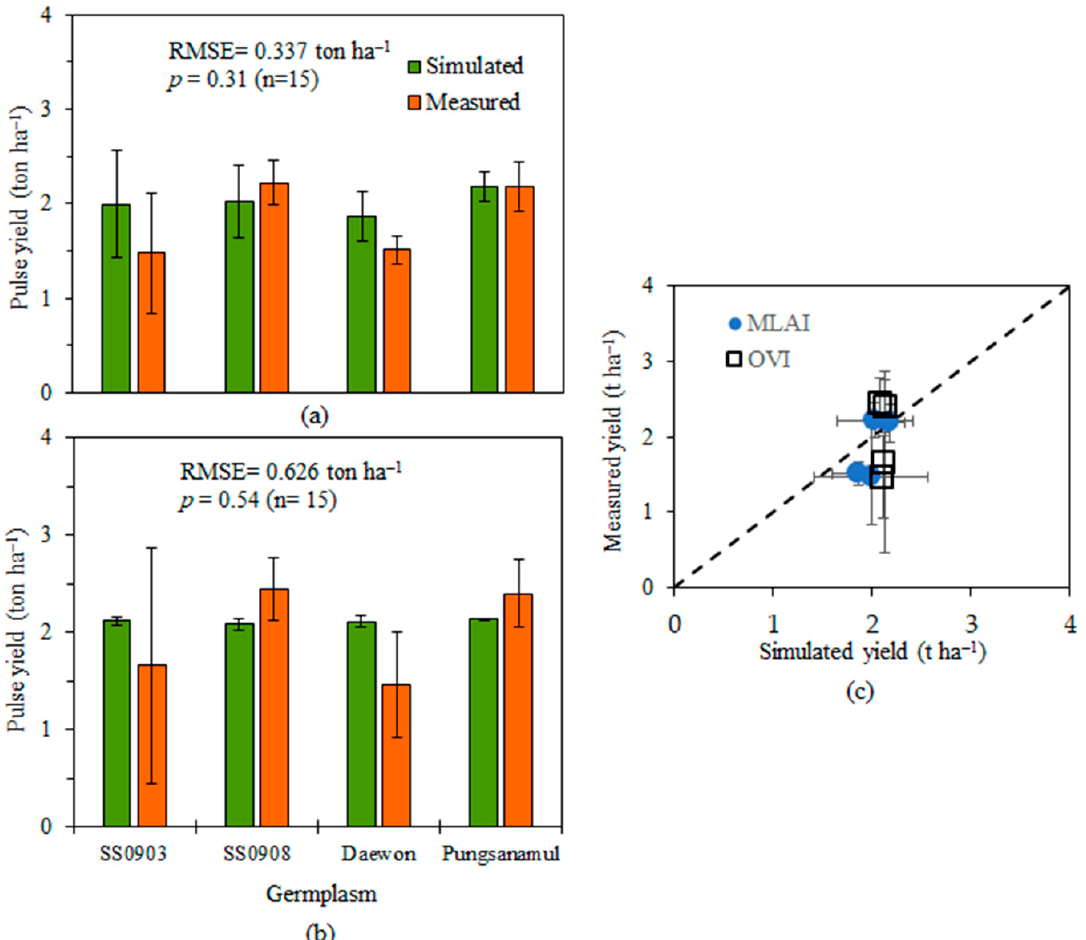
Figure 5. Comparisons between simulated and measured soybean pulse using different input options, measured leaf area index (MLAI) ( a ) and observed vegetation indices (OVI) based on proximal sensing ( b ), at Chonnam National University, showing those for both options ( c ) Gwangju, South Korea in 2017. Vertical error bars represent ± 1 SE of the mean values. RMSE and p denote root mean square error and the p value according to the two-sample t -test.